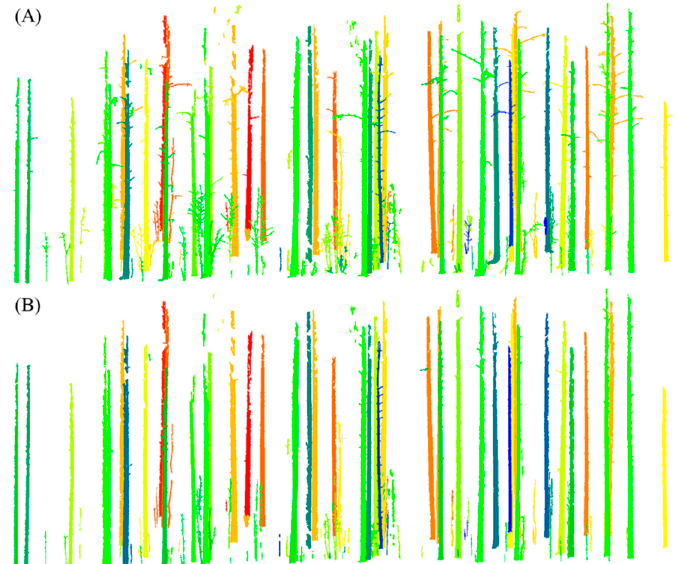
Figure 9. Illustration of the result after CC-stem-extraction ( A ) and the result after refinement ( B ).